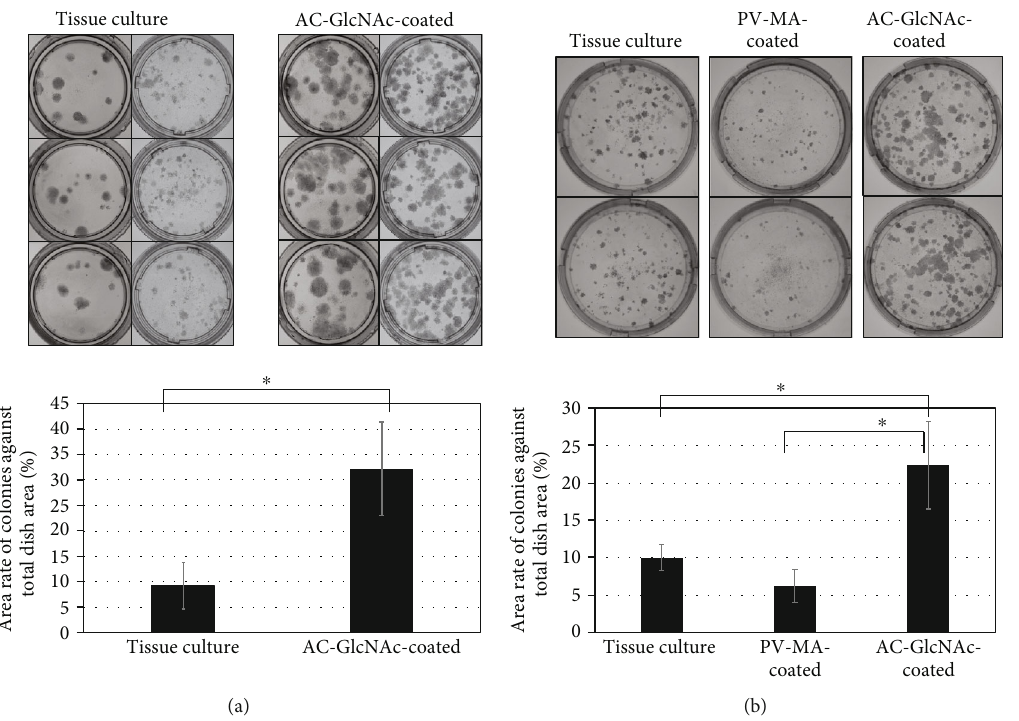
Figure 4: Colony formation of rat bone marrow cells on AC-GlcNAc-coated dishes and tissue-culture dishes. (a) Representative images and areas of colonies after 17 days of culture. ∗ P < 0 : 01 , n = 18 . (b) Representative images and areas of colonies on AC-GlcNAc-coated dishes, PV-MA-coated dishes, and tissue-culture dishes for 10 days. ∗ P < 0 : 01 , n = 3